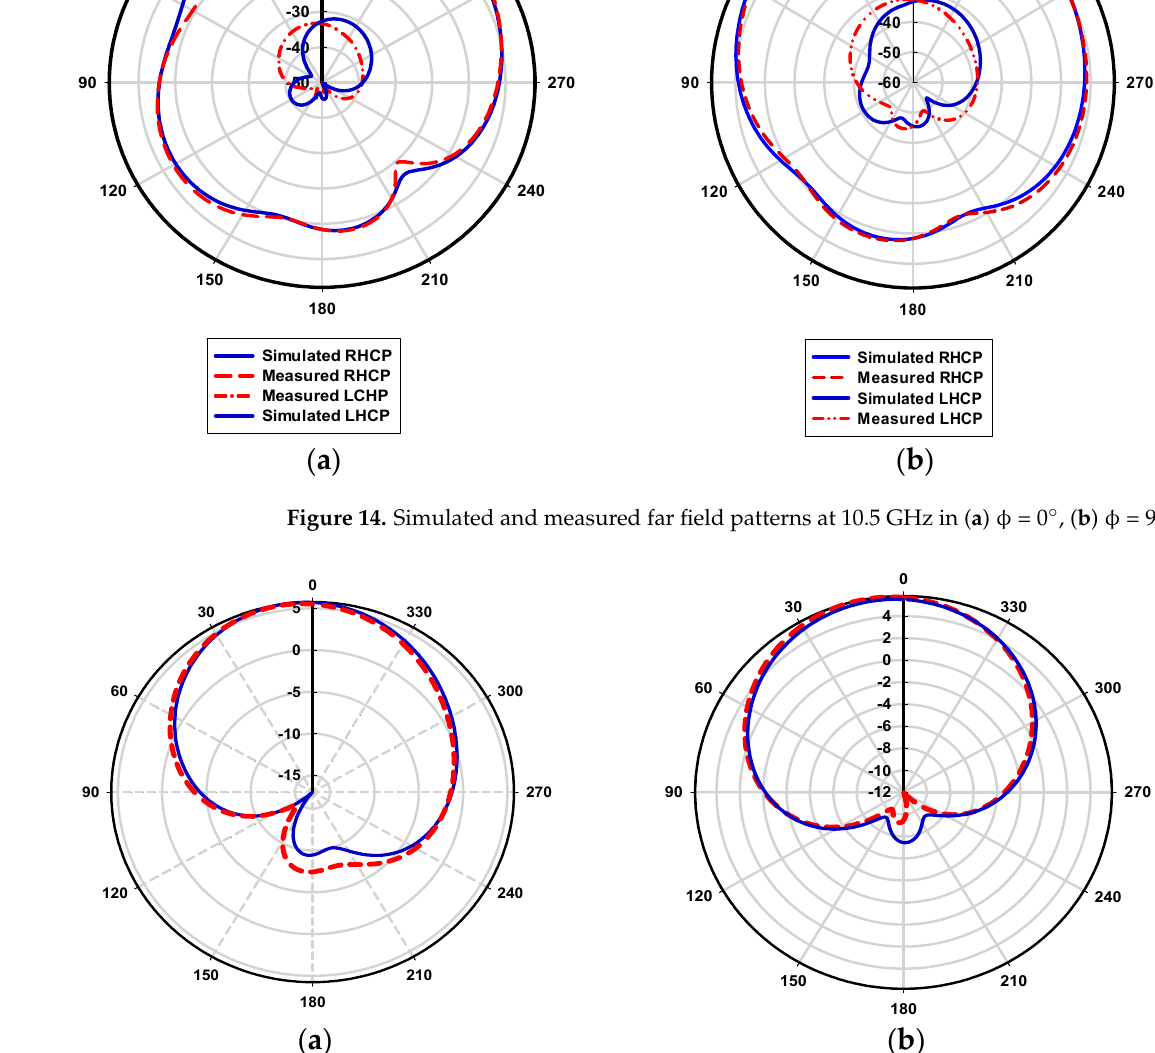
Figure 16. Simulated and measured radiation pattern at 13.13 GHz in ( a ) XY plane (E-field), and ( b ) YZ plane (H-field) of the proposed design.